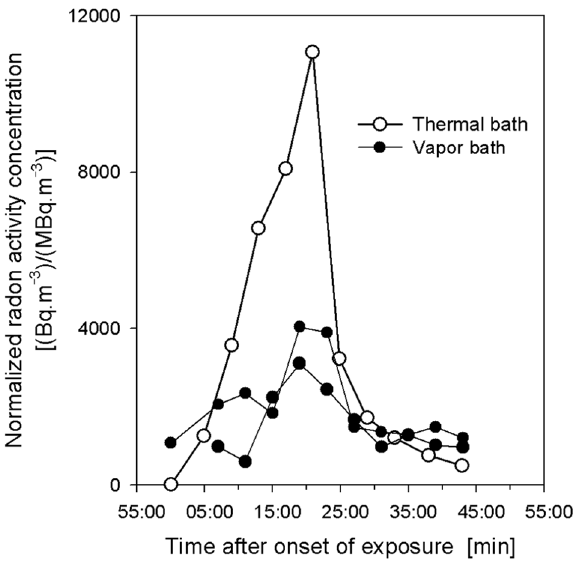
Figure 1. Exhalation curves for two measurements with a male volunteer in the vapor bath, normalized to the corresponding mean radon activity concentrations [Bq m − 3 /(MBq m − 3 )], for 20 min exposure and subsequent 20 min resting phases, and comparison with the corresponding exhalation curve obtained in the thermal bath with the same volunteer.